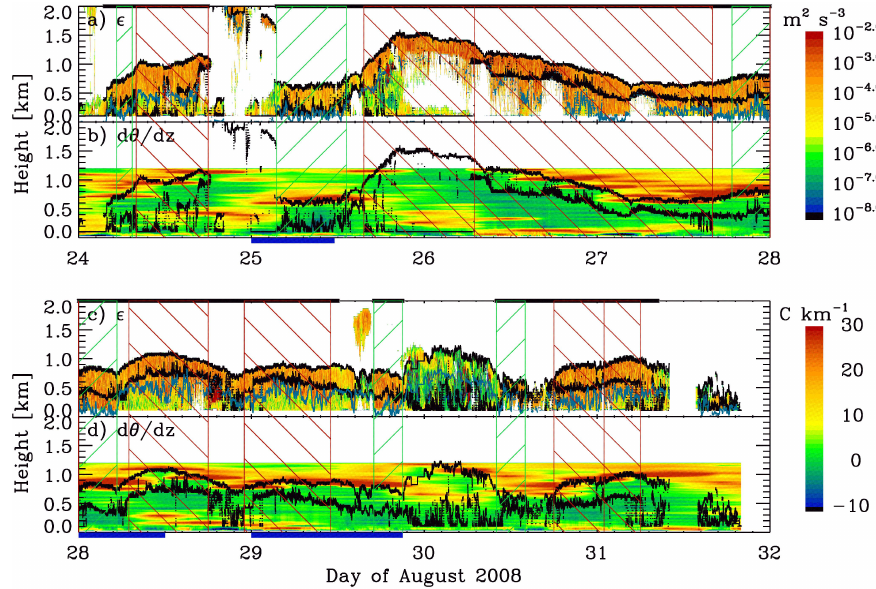
Fig. 12. Time–height contour plots of (upper) turbulent dissipation rate and (lower) vertical gradient of potential temperature for the “stra- tocumulus” time period of ASCOS. Two different 4-day periods are plotted. Cloud boundaries are given in black, while the base of the cloud-driven mixed layer is given in blue in the dissipation rate panels. Periods where the mixed layer is identified as being predominantly coupled (green) and decoupled (red) from the surface are noted with cross hatches. All time periods included in the statistical characterization in Sect. 4 are noted with the thick black bars across the top axes. Case study periods are given as blue lines along the lower time axes.